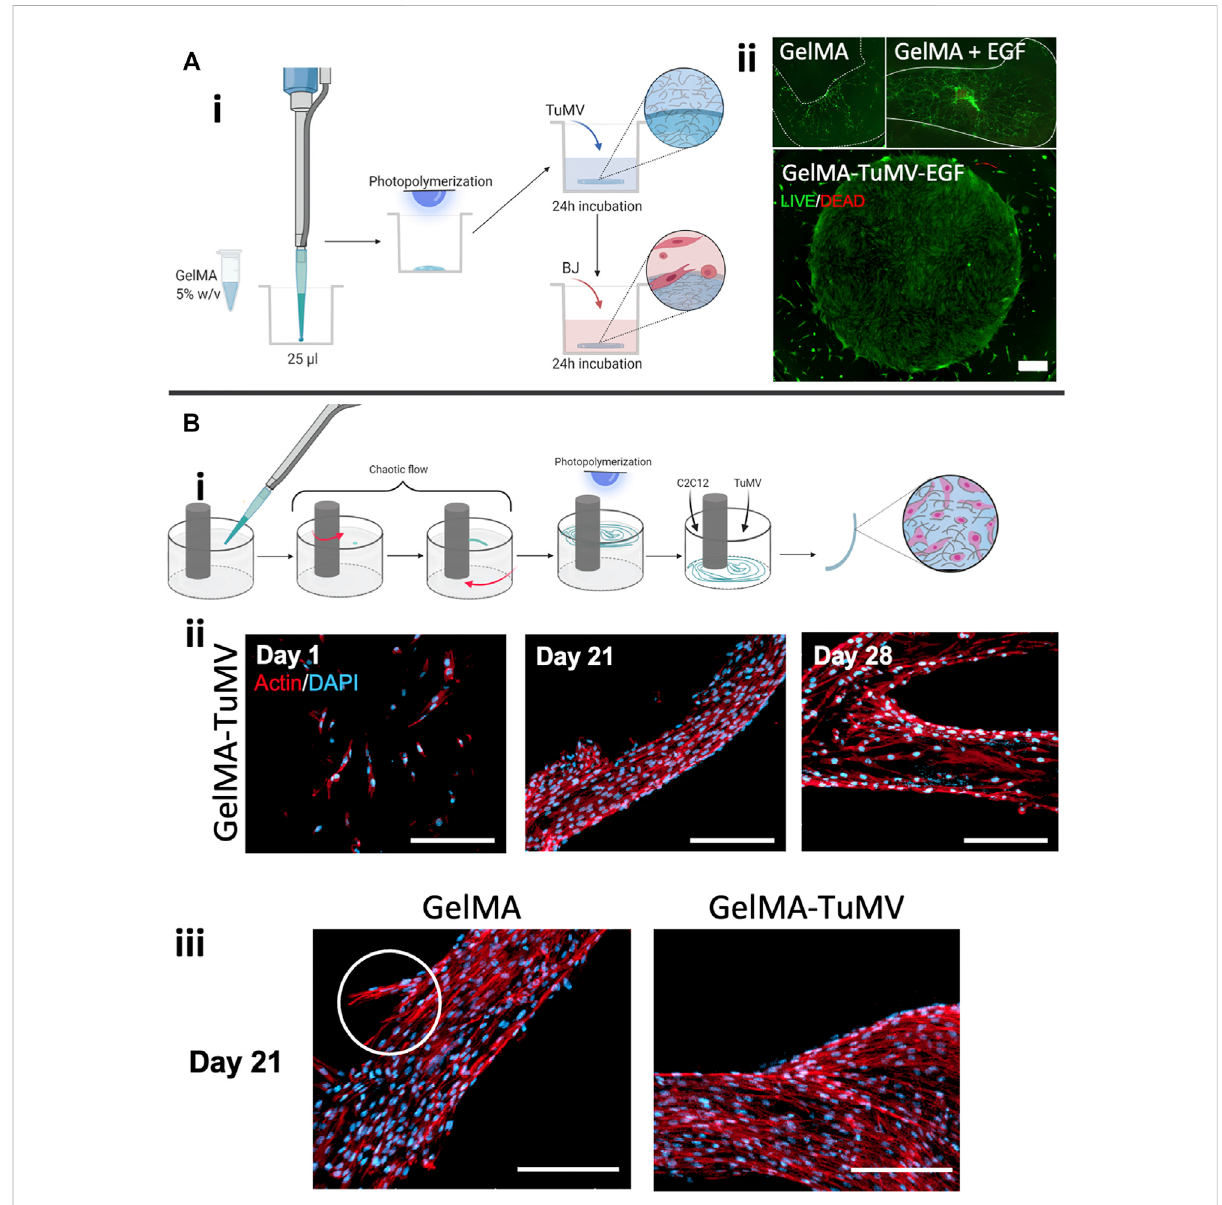
FIGURE 4 GelMA-TuMV hydrogel constructs produced by different biofabrication techniques. (A) Disk-shaped constructs produced by casting in ultra- lowattachment(ULA)plates.(i)Schematicrepresentationofthefabricationprocess.(ii)LIVE/DEAD ® assayofBJ fi